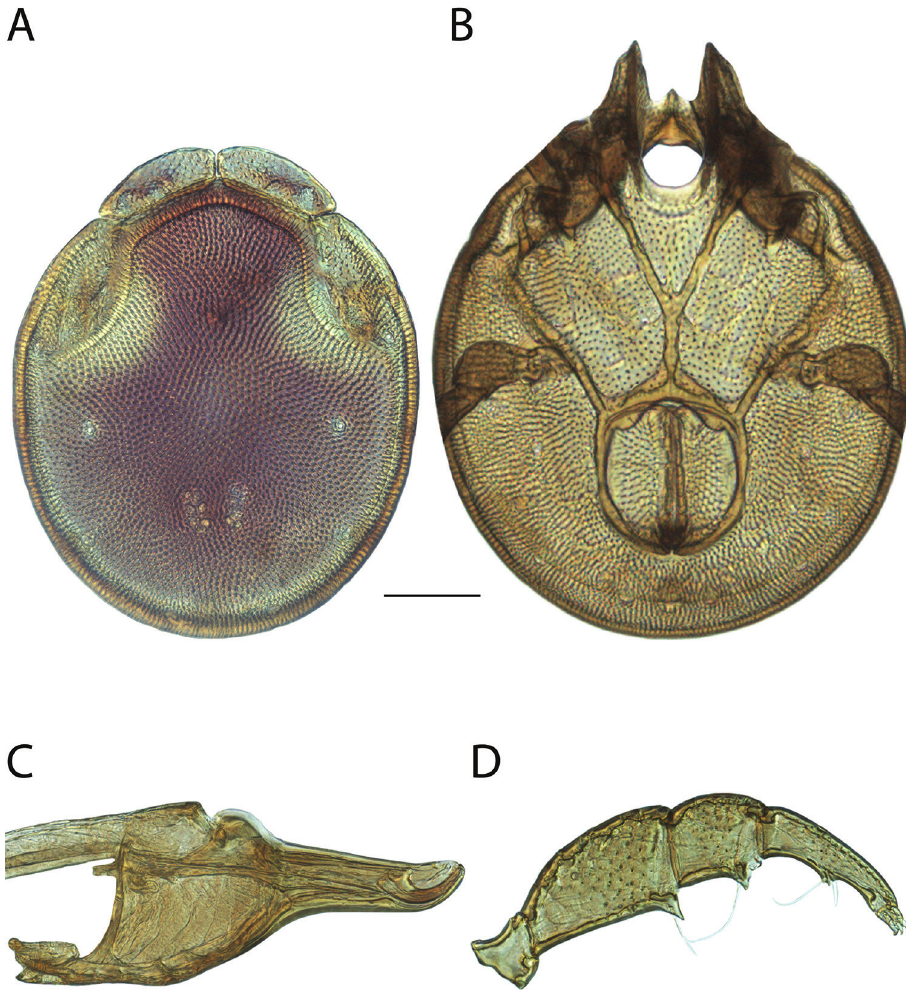
Figure 198. Torrenticola priapus sp. n. male: A dorsal plates B venter (legs removed) C subcapitulum D pedipalp (setae not accurately depicted). Scale = 100